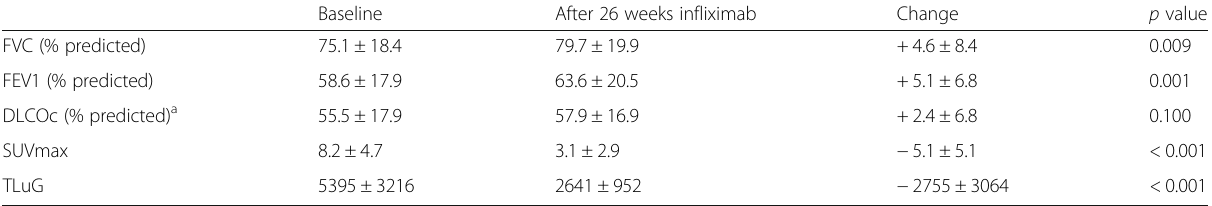
Table 2 Pulmonary function, SUVmax and TLuG at baseline and after 26 weeks infliximab treatment, n = 27; mean ± SD Baseline After 26 weeks